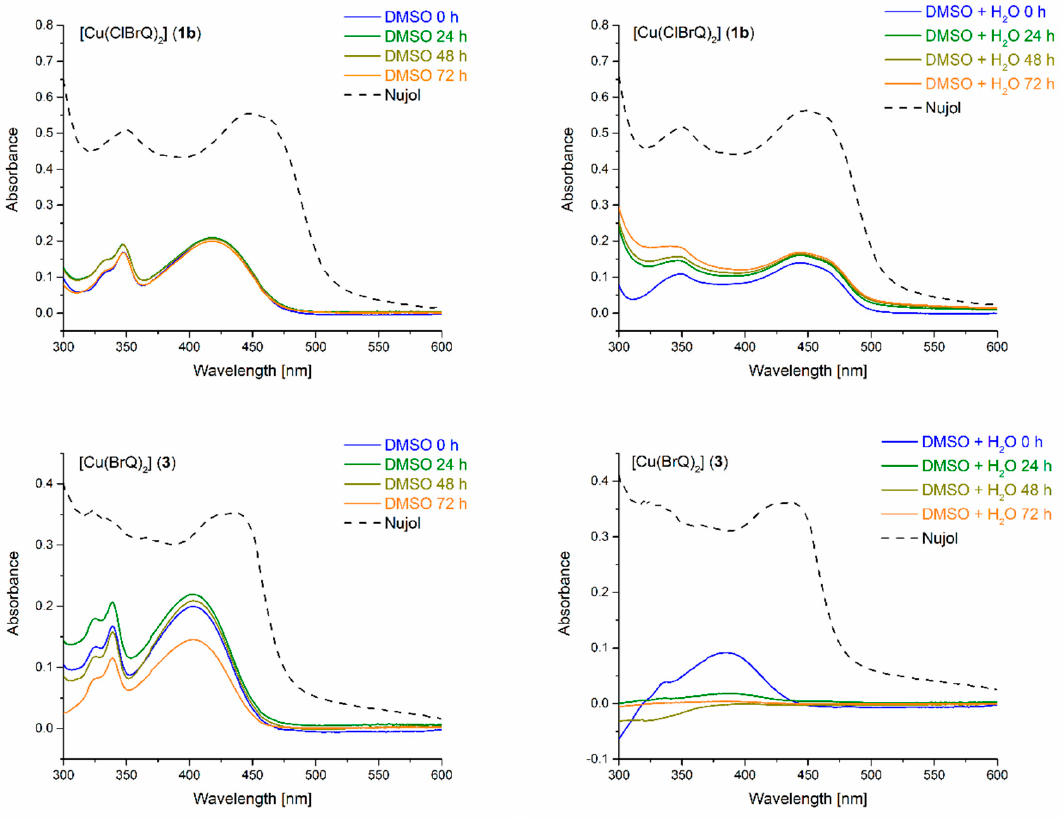
Figure 2. UV-VIS spectra of 1b ( top ) and 3 ( bottom ).